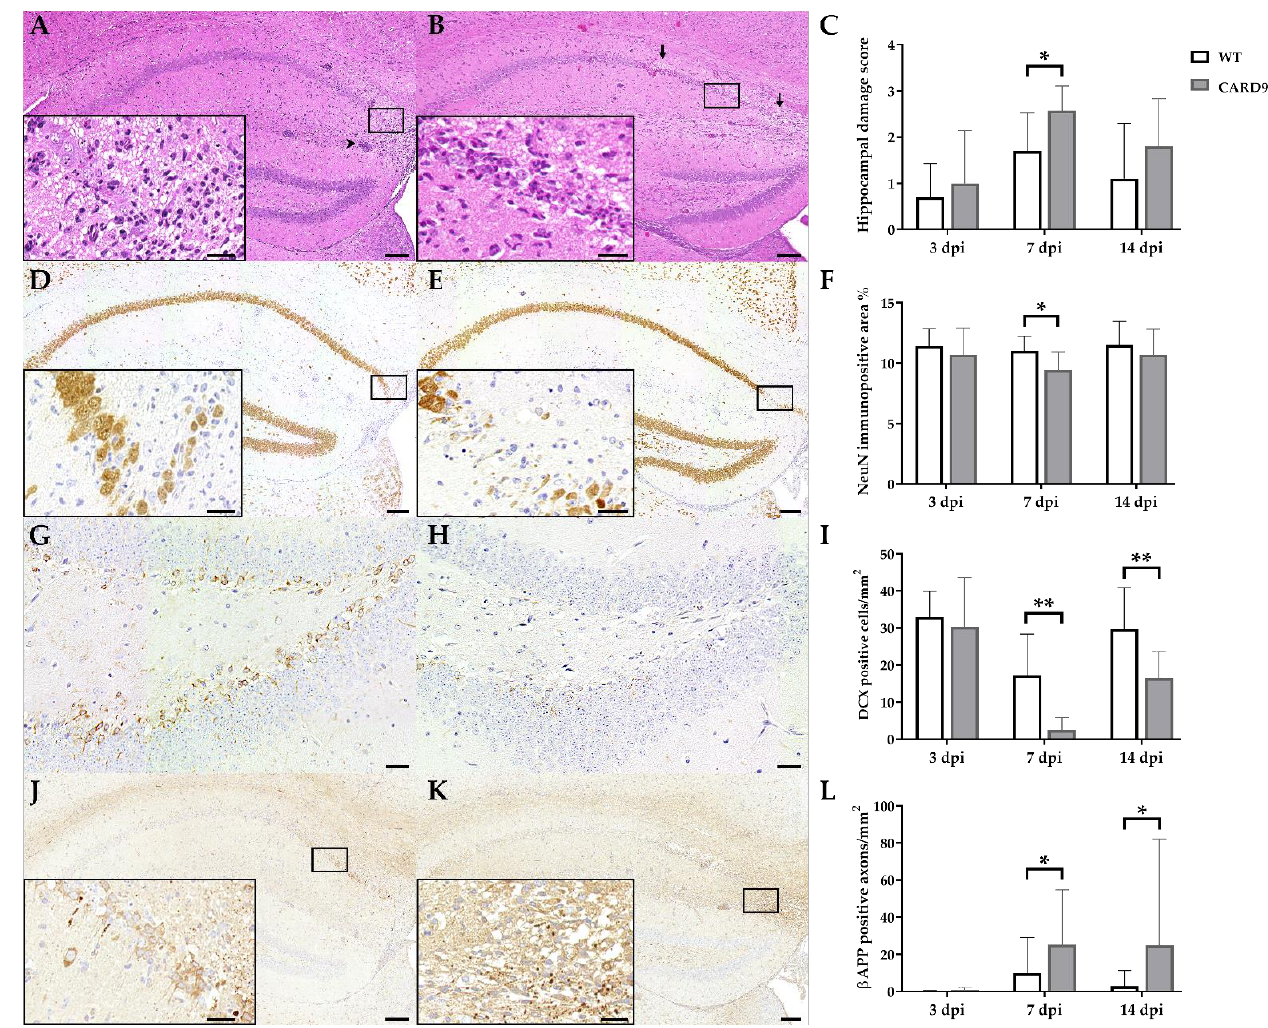
Figure 1. Hippocampal damage in C57BL/6 wild-type (WT) mice and CARD9-deficient (CARD9 − / − ) mice following Theiler’s murine encephalomyelitis virus (TMEV) infection. Hematoxylin and eosin staining of the hippocampus with ( A ) mild neuronal loss and perivascular cuffs (arrowhead) of a WT mouse and ( B ) marked neuronal loss (arrows) of a CARD9 − / − mouse at 7 days post infection (dpi). ( C ) Histological scoring of hippocampal damage. NeuN-specific immunohistochemistry of ( D ) a WT mouse with mild loss of neuronal nuclear antigen (NeuN) + mature neurons in the hippocampus and of ( E ) a CARD9 − / − mouse with prominent loss of NeuN + neurons in the CA1 region at 7 dpi. ( F ) Percentage of NeuN immunopositive area in the hippocampus. Doublecortin (DCX)-specific immunohistochemistry in the hippocampal dentate gyrus of ( G ) a WT mouse and ( H ) a CARD9 − / − mouse with marked loss of DCX + cells at 7 dpi. ( I ) Quantification of DCX + neuronal progenitor cells in the dentate gyrus. β -APP-specific immunohistochemistry of ( J ) a WT mouse with a marginal number of β -APP + axons in the hippocampus and ( K ) a CARD9 − / − mice with several swollen β -APP + axons in the hippocampus at 7 dpi. ( L ) Quantification of β -APP + axons in the hippocampus. ( C , F , I , L ) Significant differences between WT and CARD9 − / − mice are labelled with asterisks (* p ≤ 0.05; ** p ≤ 0.01; Mann–Whitney U -test). Three dpi: WT n = 10, CARD9 − / − n = 10; 7 dpi: WT n = 10, CARD9 − / − n = 9; 14 dpi: WT n = 10, CARD9 − / − n = 10. Data are displayed as mean with SD. Immunohistochemistry, scale bar: 100 µ m ( A , B , D , E , J , K ) and 20 µ m ( A , B , D , E , J , K , inserts; G , H ).